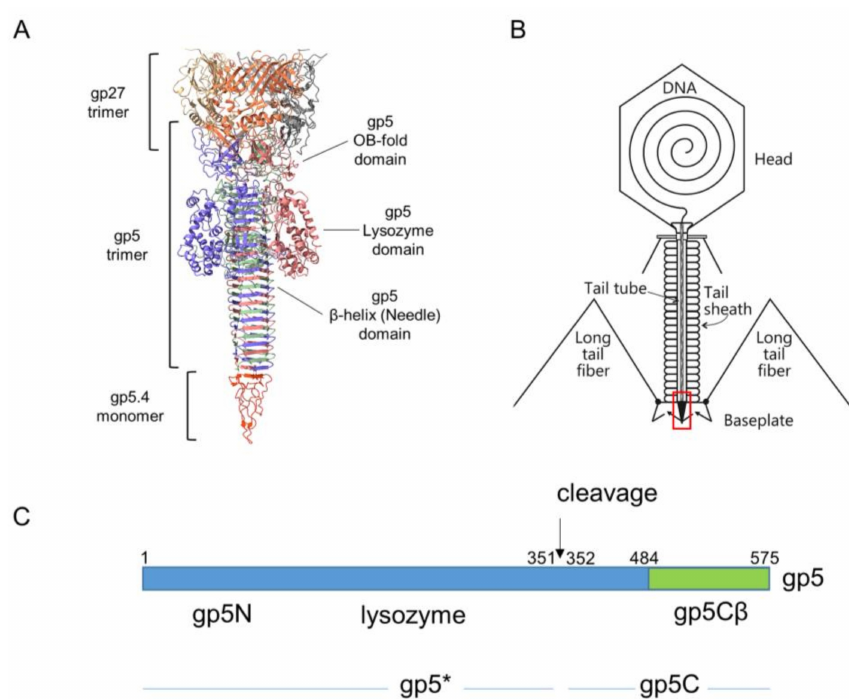
Figure 1. ( A ) Ribbon diagram of T4 central spike complex extracted from T4 baseplate structure [5]. Each chain shown in distinct colour. The gp27 hub protein forms an extension to the tail tube. It holds the N-terminal oligosaccharide / oligonucleotide binding fold (OB-fold) domain of the gp5 spike protein in its central channel. The gp5 spike also contains a middle lysozyme domain and a C-terminal β helix domain. The blunt tip of the β helix is sharpened by spike tip gp5.4. ( B ) Schematic structure of the T4 phage particle [8]. Location of the spike complex shown as a red rectangle. ( C ) Schematic of the gene 5 derived products. The gp5 protein is cleaved at position 351 after its assembly into the phage, resulting in gp5* and gp5C [11]. The carboxyl-terminal part of gp5C (green) encompassing the triple β helix that starts at residue 484 was cloned onto a plasmid